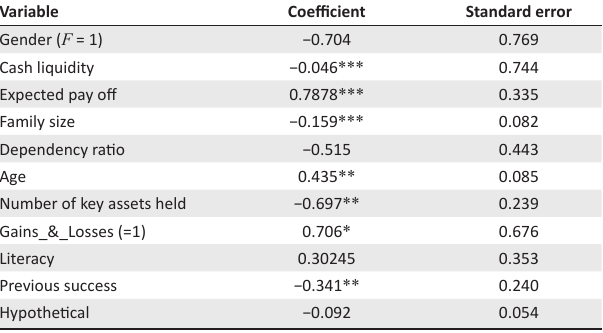
TABLE 3: Dependent variable is risk aversion coefficient (random effects results).